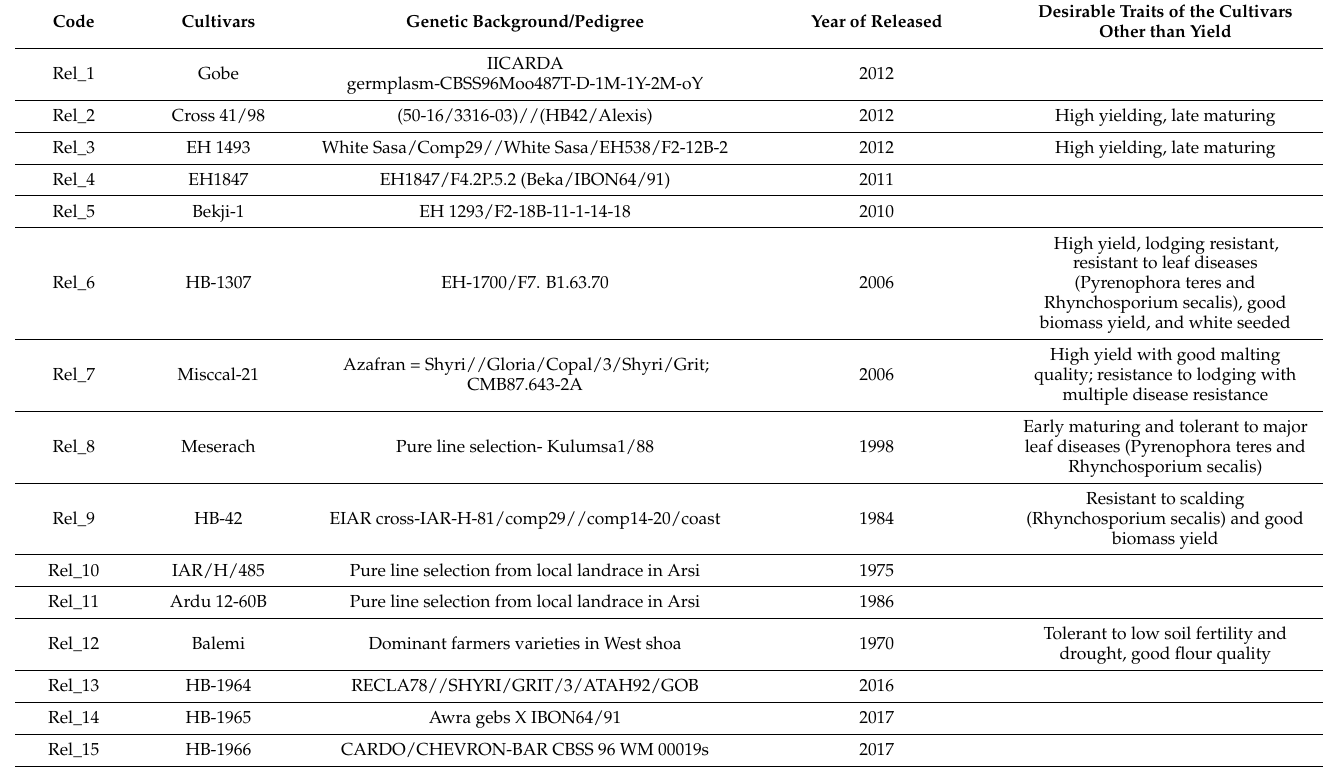
Table 2. List of Ethiopian released cultivars and their desired